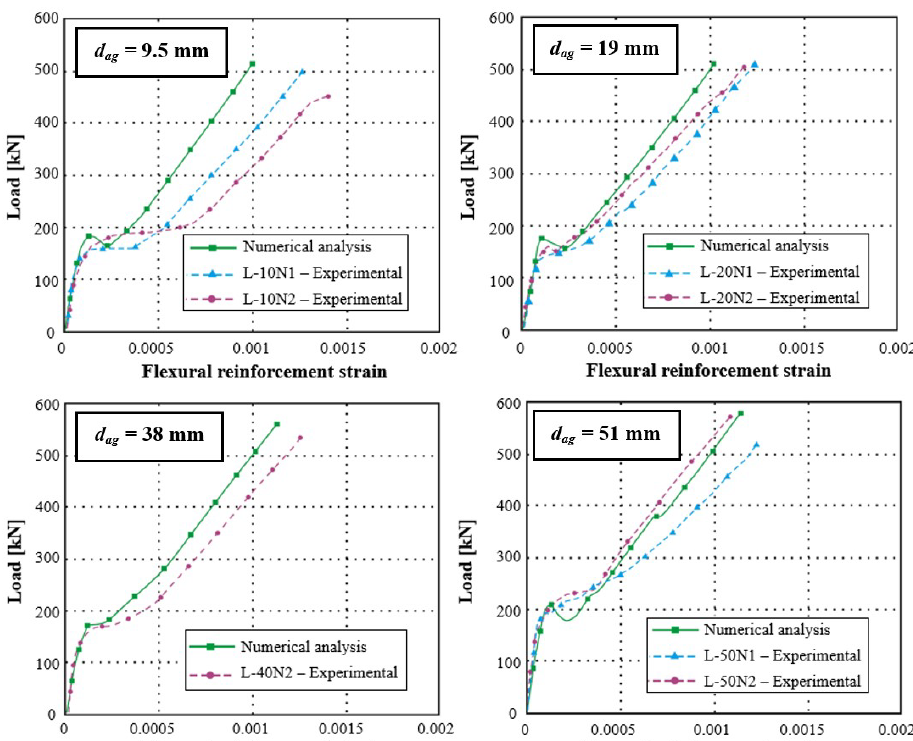
Figure 7. Load versus flexural reinforcement strain curves for L-Series